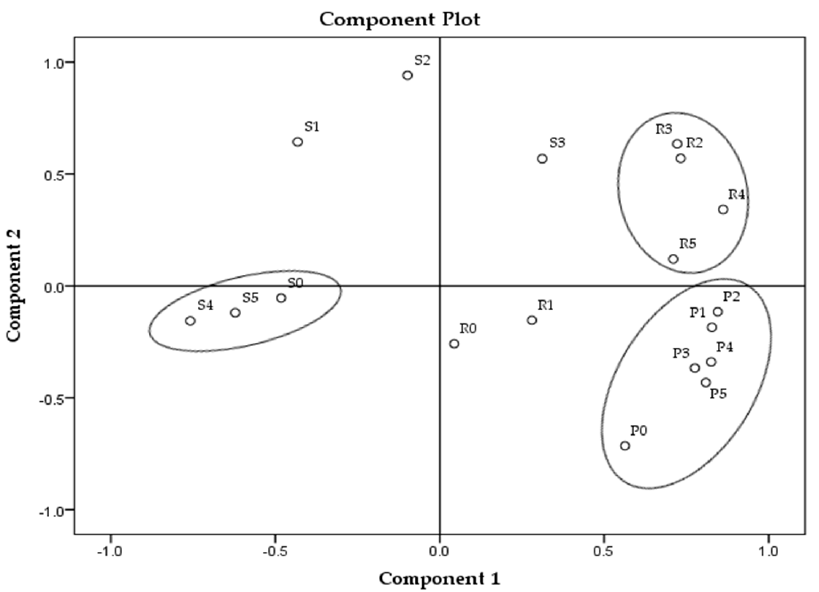
Figure 1. Principal component analysis for all analyses on the obtained samples. * Samples’ description is given in Table 1.